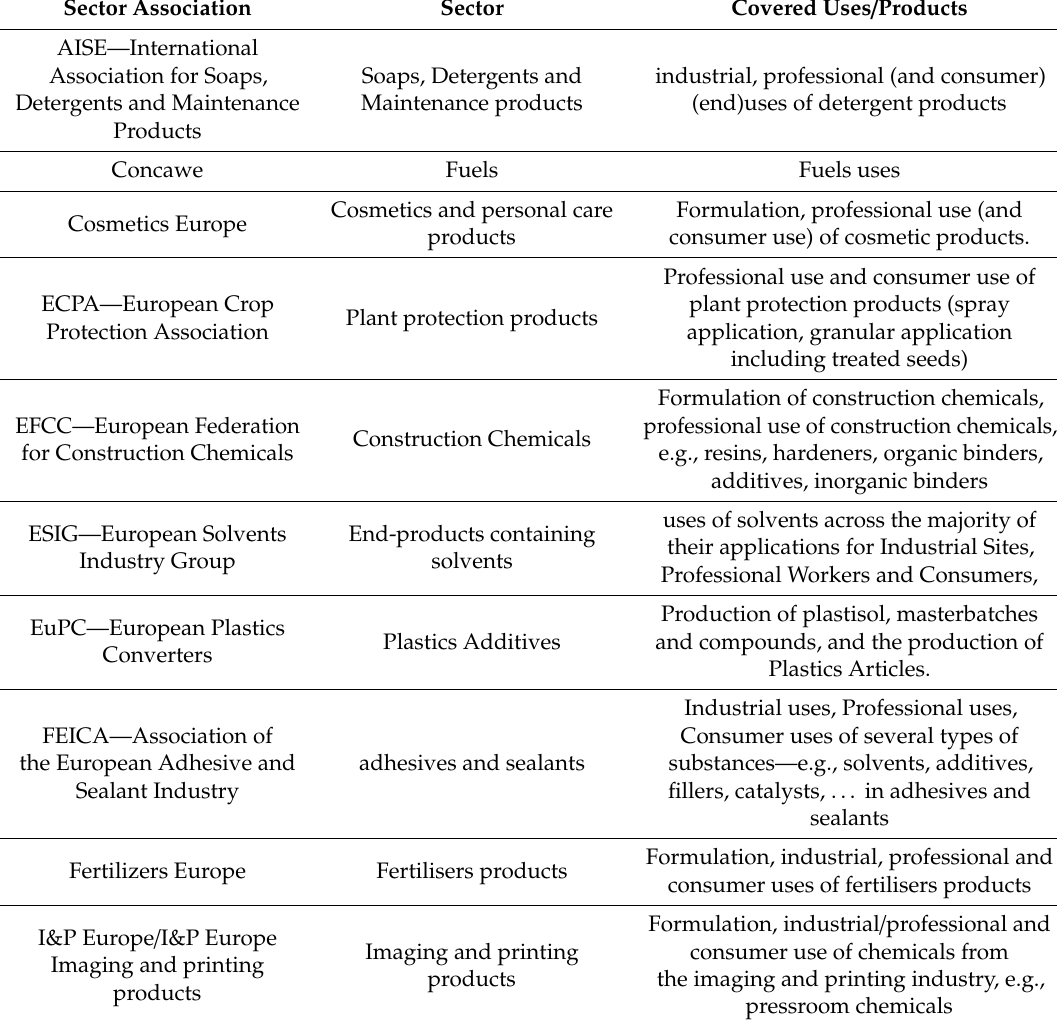
Table 3. Use Maps as available on the European Chemicals Agency (ECHA) web